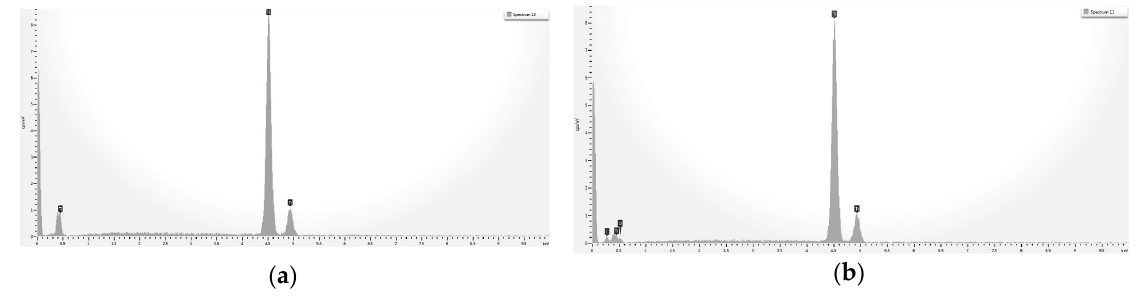
Figure 4. EDX spectra of control ( a ) and HY-coated ( b ) titanium implant.